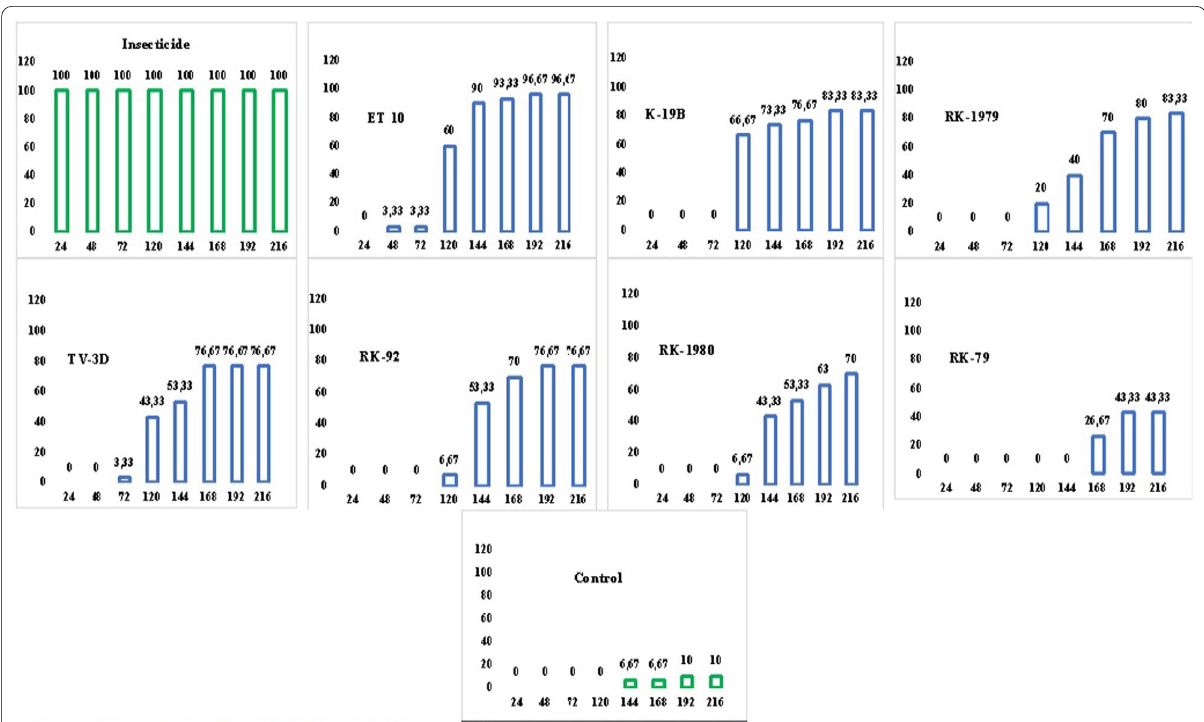
Fig. 1 Virulence effect of the applications on 1st and 2nd larval instars of Cymbalophora